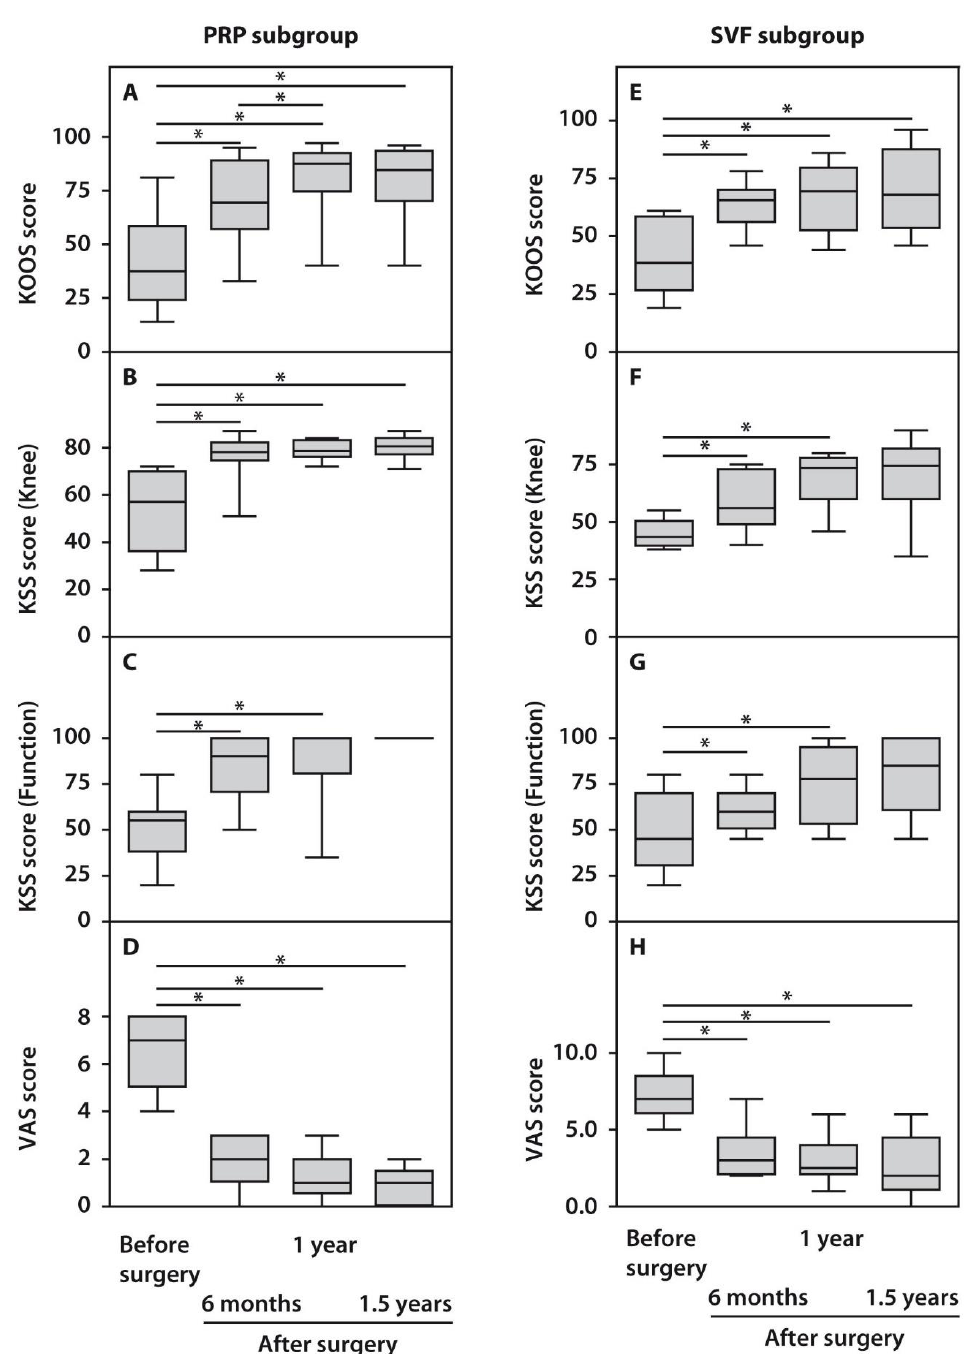
Figure 1. Functional characteristics of patients with OA subjected to HTO therapy with post-surgery injections of PRP ( A – D ) or SVF ( E – H ) prior to and in the course of follow-up. All statistically significant differences are indicated with an asterisk (*).